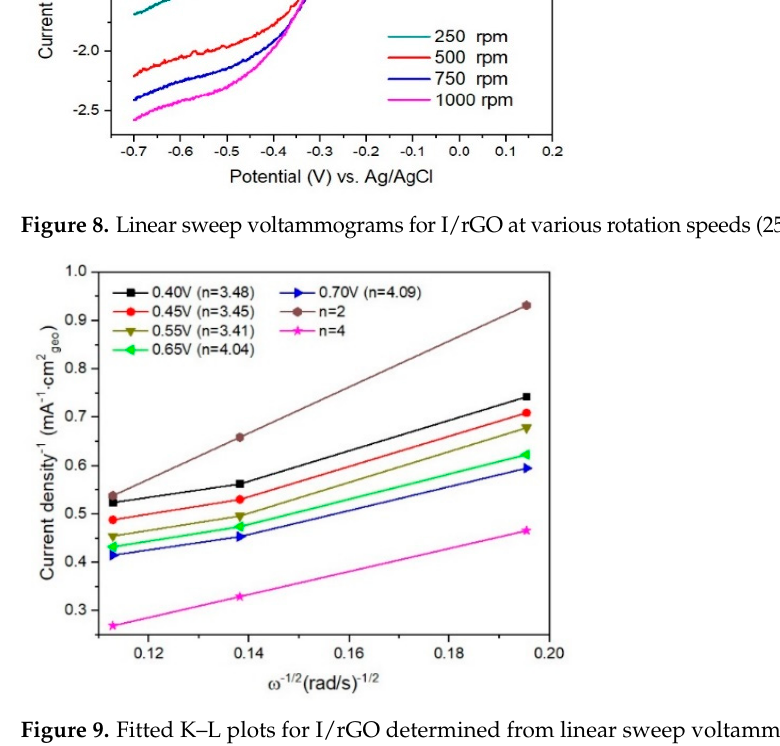
Figure 9. Fitted K–L plots for I/rGO determined from linear sweep voltammograms.